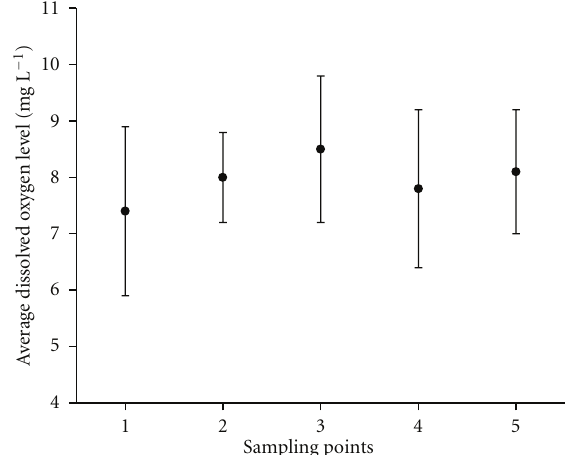
Figure 5: Average dissolved oxygen concentrations (surface water) for all of the sampling points.